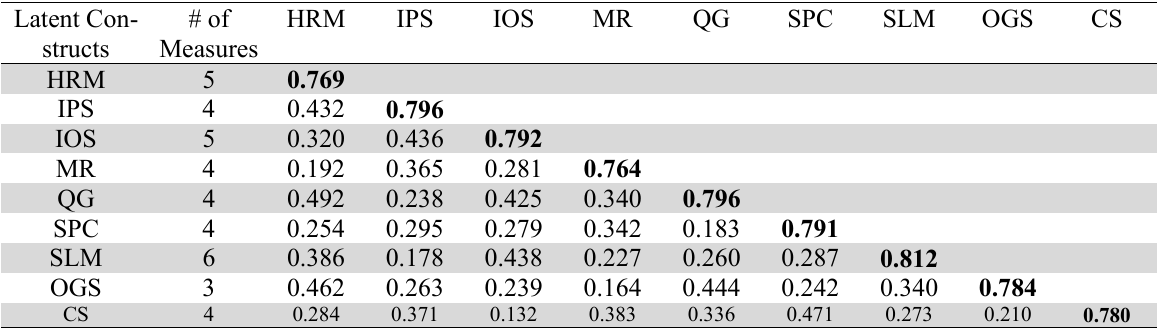
Latent Con- structs